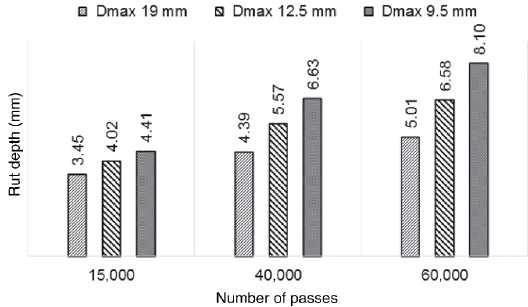
Figure 5: Rutting test results at 60°C in air. From the test results for the three gradations using the same type of asphalt binder at 60°C with 30,000 cycles (60,000 passes) in air, it shows that the resistant of rutting of maximum aggregate size of 19 mm is the